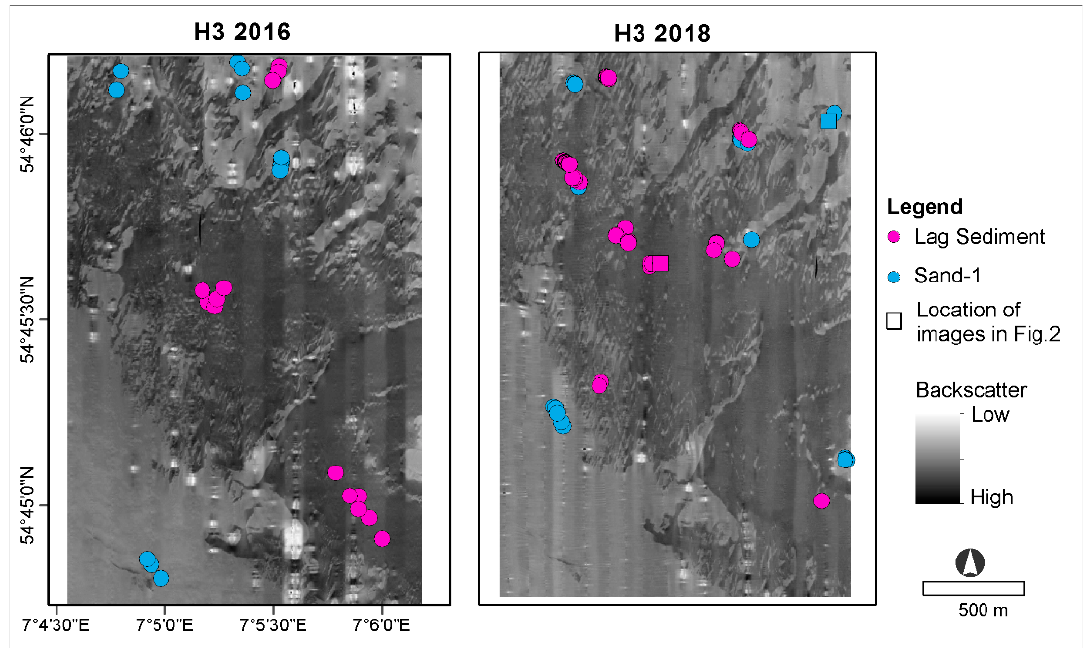
Figure 3. Side-scan mosaics collected in 2017 and 2018 with the location of sampling stations in H3. The locations of the images presented in Figure 2 are represented by squares.